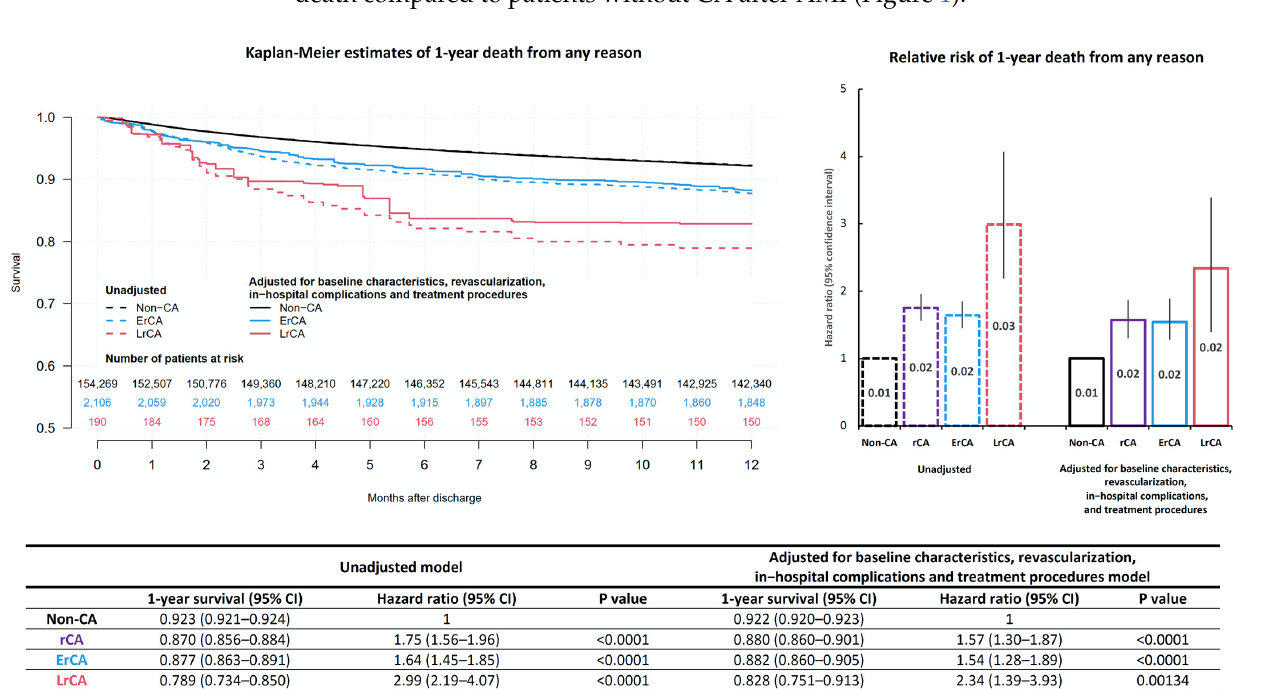
Figure 1. Central illustration. Risk of death from any reason for patients discharged home after